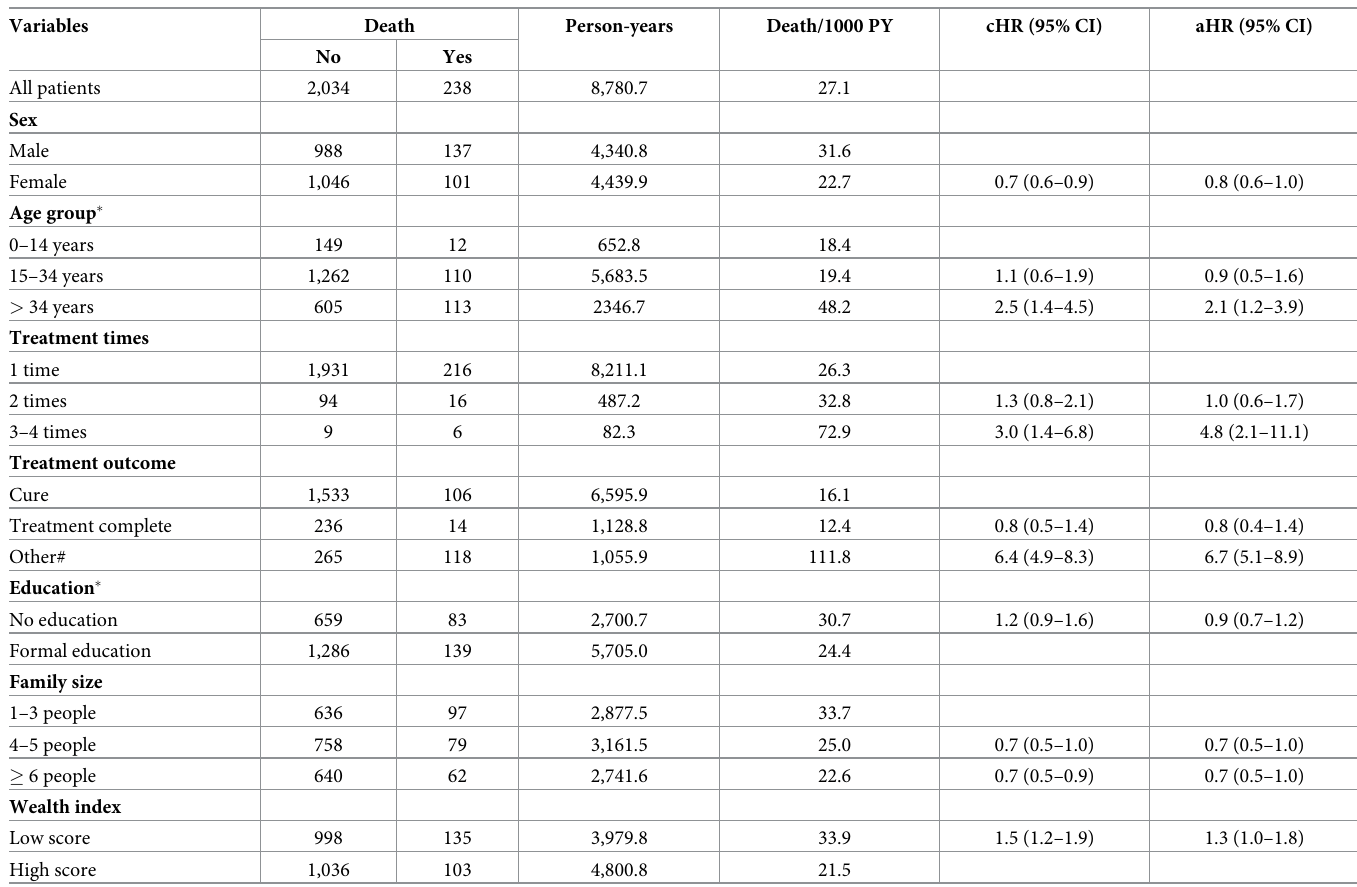
Table 6. Risk factors of death among TB patients in Dale district, South